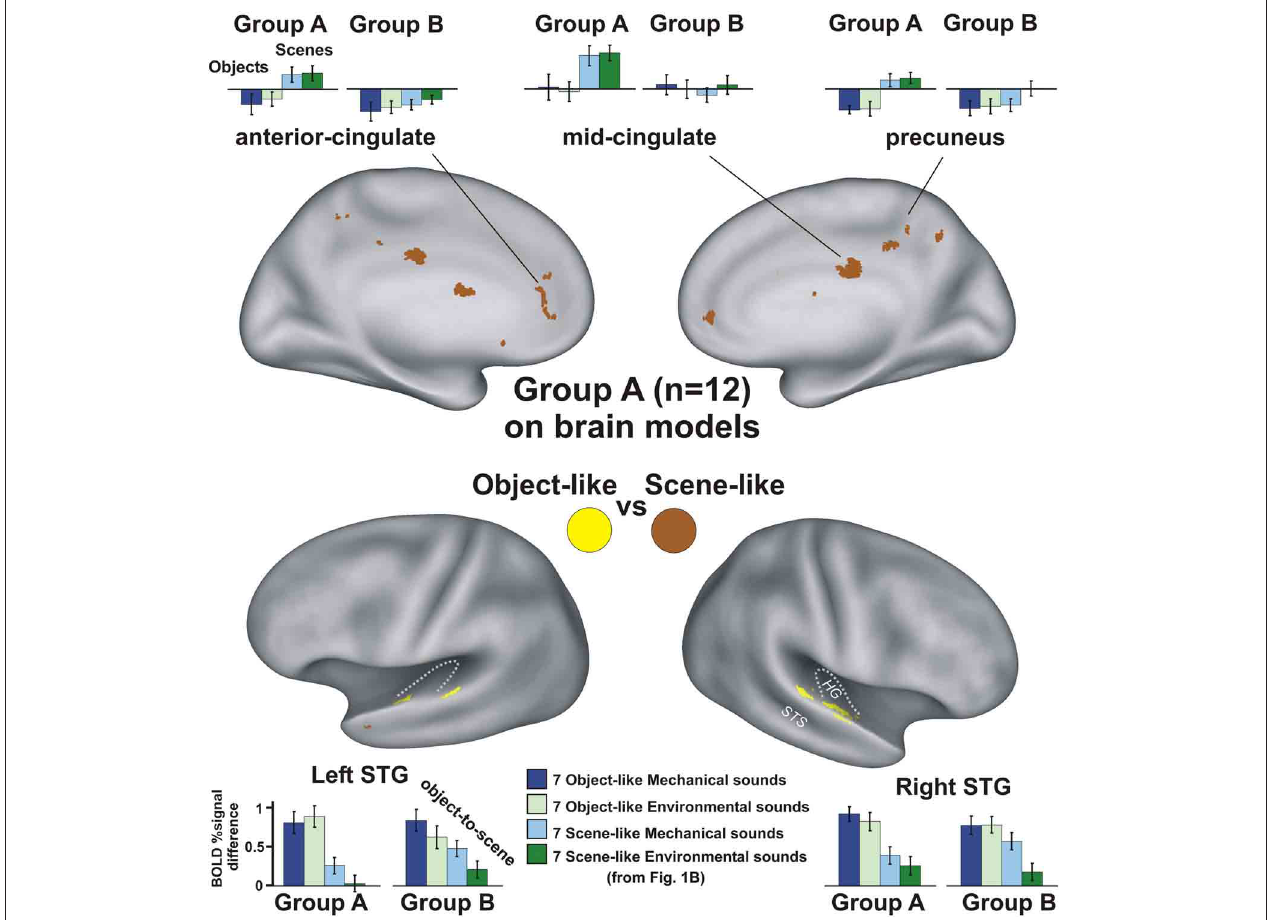
α < 0 . 05, corrected). Histograms show activation profiles (normalized relative to responses to silent events) for participants from both Group A ( n = 12; left-most charts) and B ( n = 19; right).